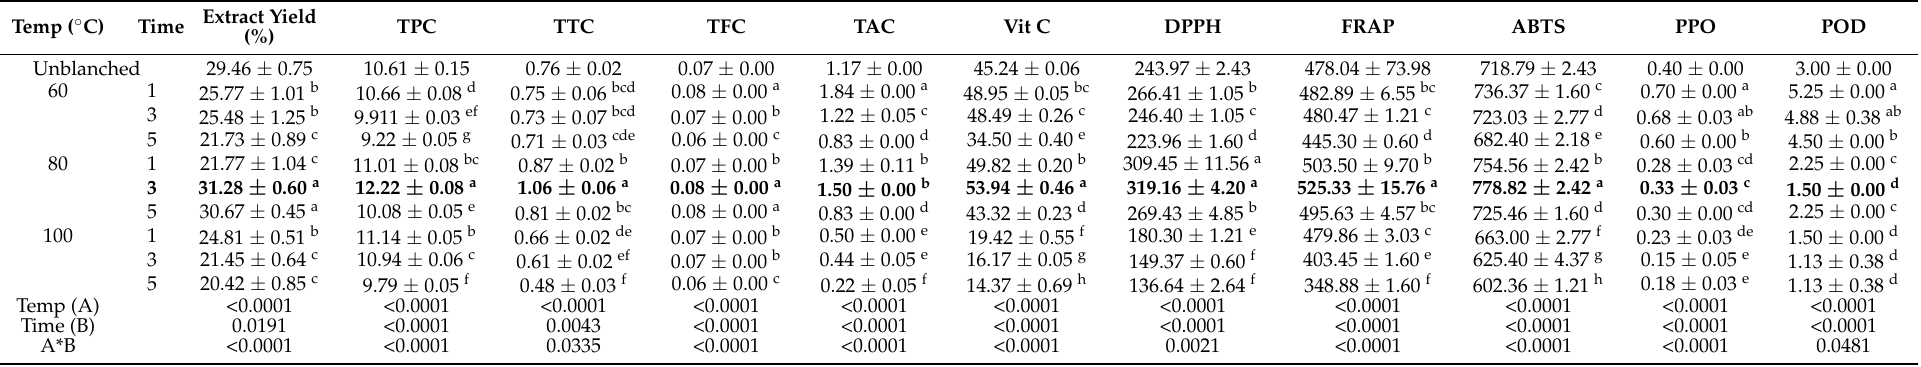
Table 2. Extraction yield, bioactive compounds, enzyme activity and antioxidant activity of ethanol (70% ( v/v )) extracts from blanched (60, 80 and 100 ◦ C for 1, 3 and 5 min) ‘Wonderful’ pomegranate